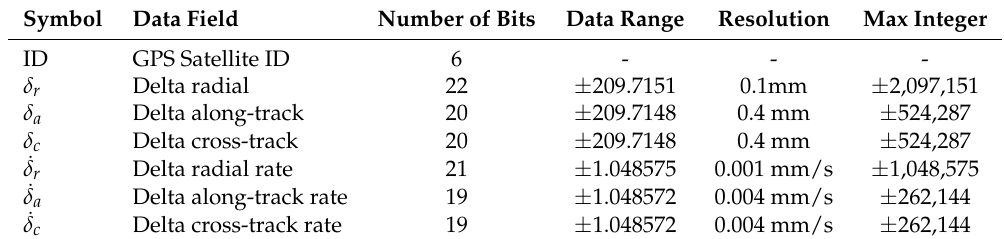
Table 2. Satellite specific part of RTCM 10,403.2 message